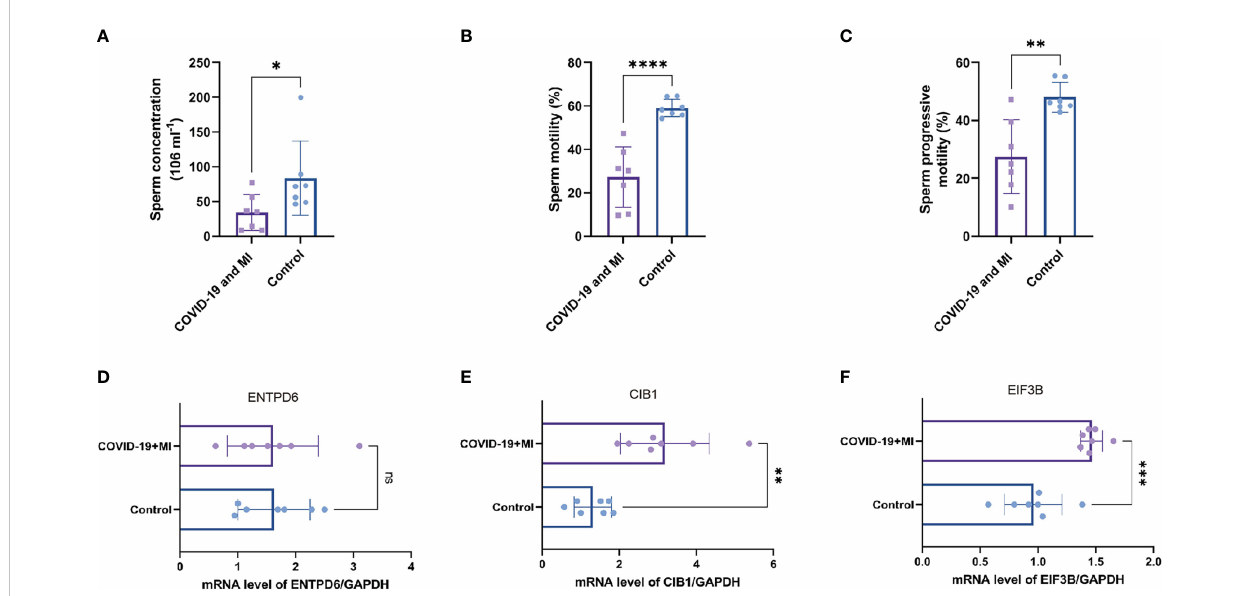
FIGURE 9 Patient ’ s semen comparisons and expression analysis of three hub CORGs. The levels of sperm concentration (A) , sperm motility (B) , and progressive motility (C) between the patient (COVID-19 and MI) and control groups. The mRNA levels of ENTPD6/GAPDH (D) , CIB1/GAPDH (E) , and EIF3B/ GAPDH (F) between the patient and control groups. * indicates P < 0.05, ** indicates P < 0.01, *** indicates P < 0.001, *** indicates P < 0.0001. CORGs, COVID-19-related differentially expressed genes; MI, male